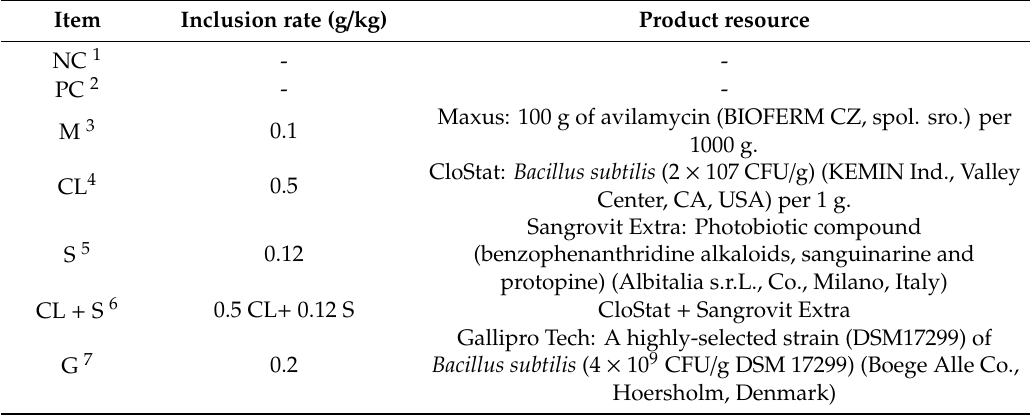
Table 1. Experimental groups and inclusion rates of feed additives used during the feeding trial period (day